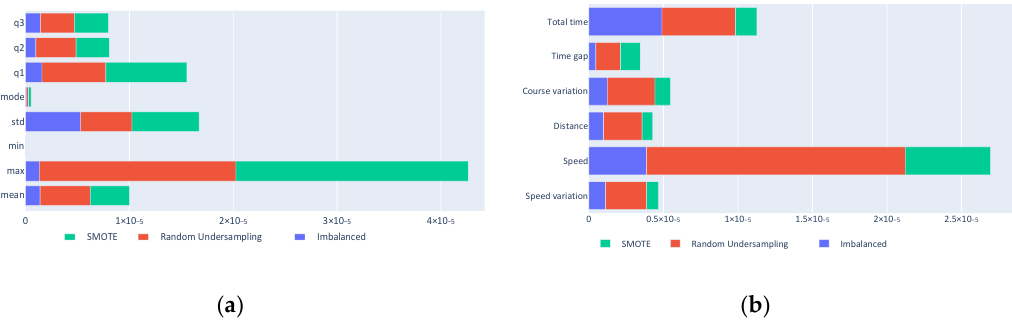
Figure 11. ( a ) Statistics predictor importance; ( b ) Feature predictor importance.